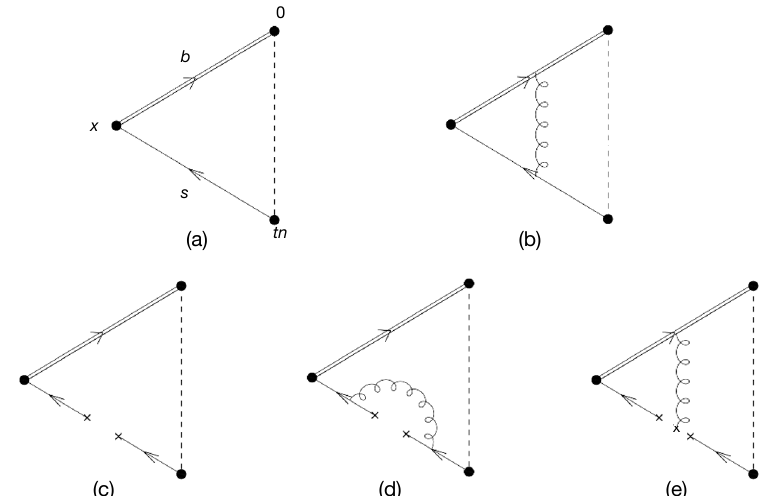
Figure 1 . The diagrams contributing to the correlation function (2.20): (a) LO loop; (b) one of the gluon radiative corrections; (c) quark condensate contribution in LO; (d) one of the gluon ra- diative corrections to quark condensate; (e) quark-gluon condensate contributions. The double line describes the heavy ( b -quark) e(cid:11)ective (cid:12)eld, the point at x corresponds to the pseudoscalar inter- polating current, the dashed interval connecting the points 0 and tn on the light-cone indicates the bilocal operator interpolating the meson DA. All possible diagrams at O ( (cid:11) s ) can be found in [20]. external momentum transfer takes place through the virtual quark and antiquark